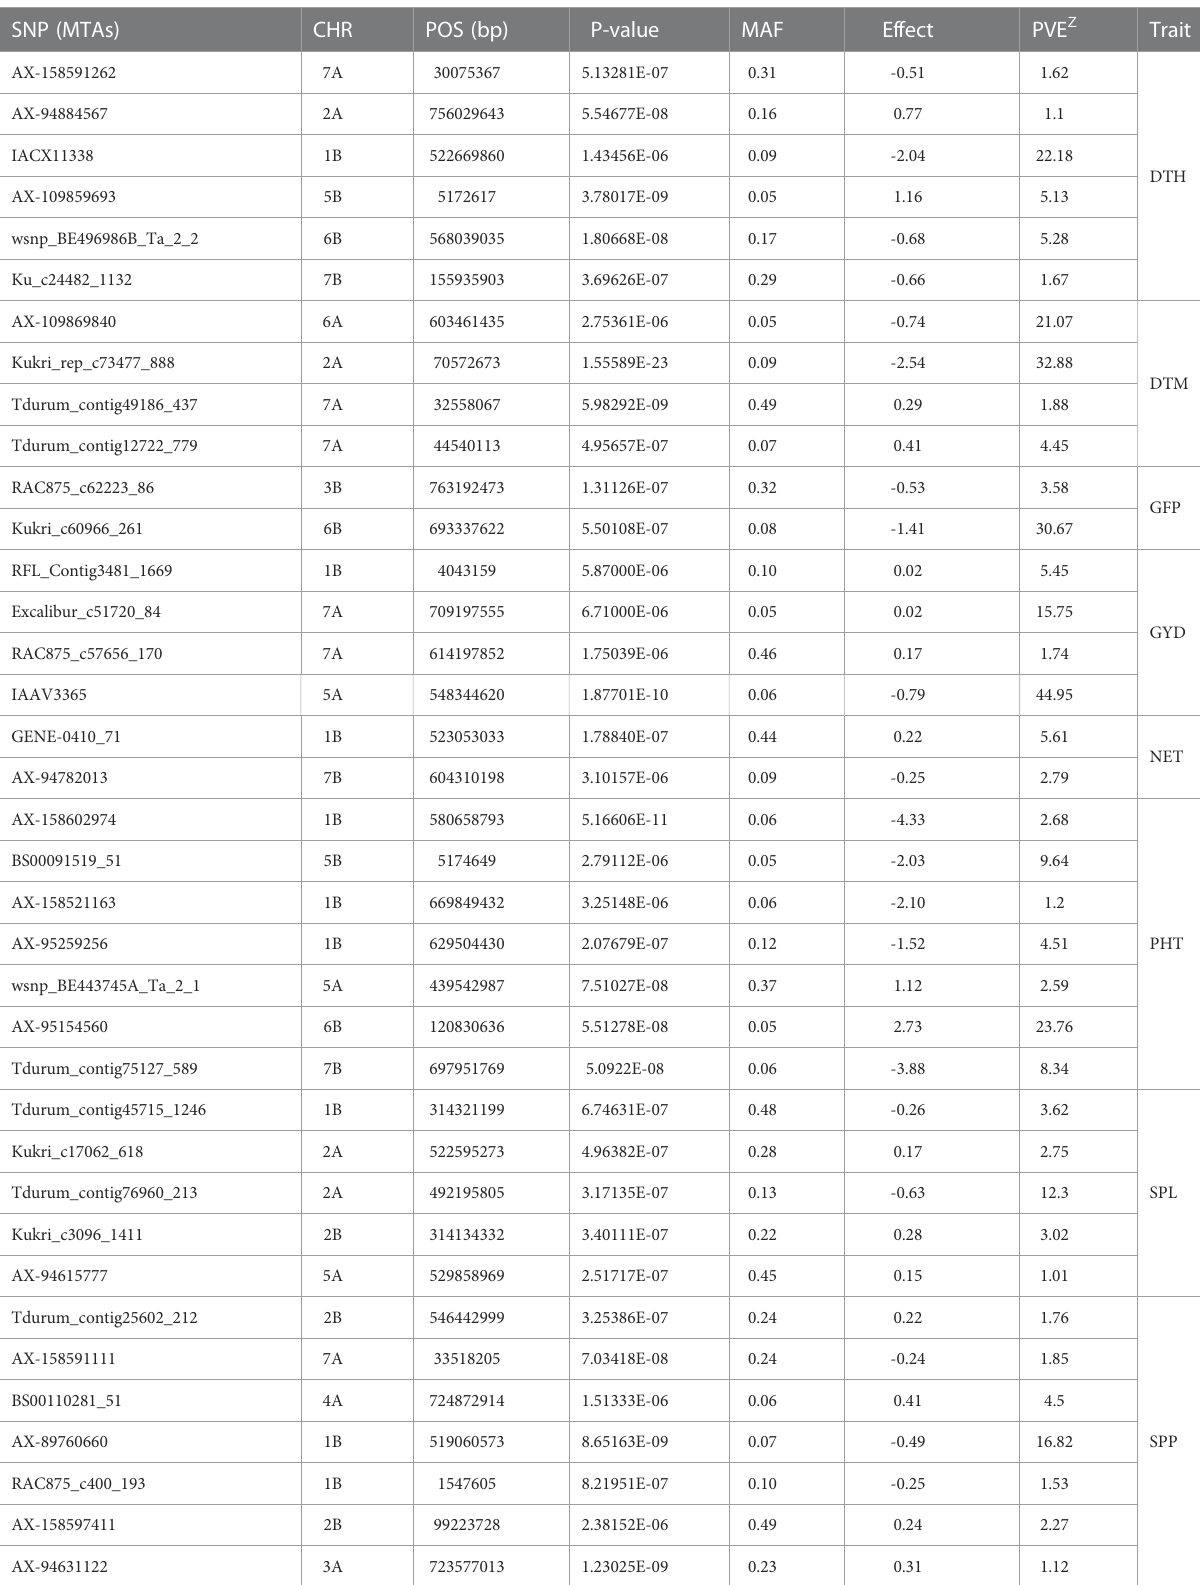
TABLE 4 Summary of signi fi cant marker-trait associations for the nine traits revealed based on the combined data of the fi ve locations on each durum wheat chromosome (CHR). SNP (MTAs) CHR Effect PVE Z